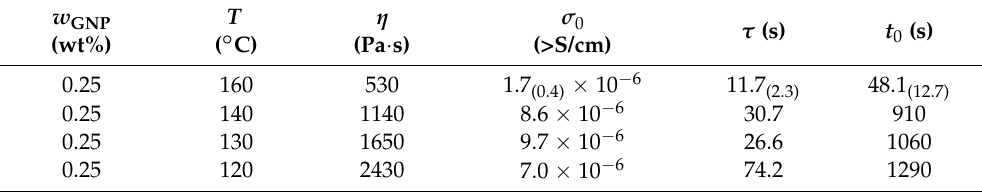
Table 2. Fitting results of the logistic growth model, Equation (5), describing conductivity growth in EVA/GNP composites with varying composite melt viscosities (numbers in parentheses represent the standard deviation across different